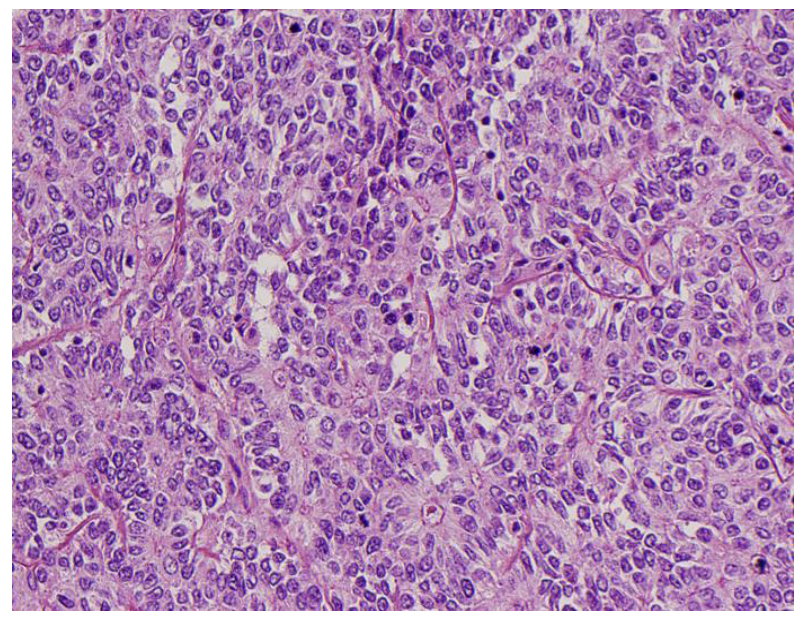
FIGURE 6. Section of ureter with endometrioid adenocarcinoma forming solid